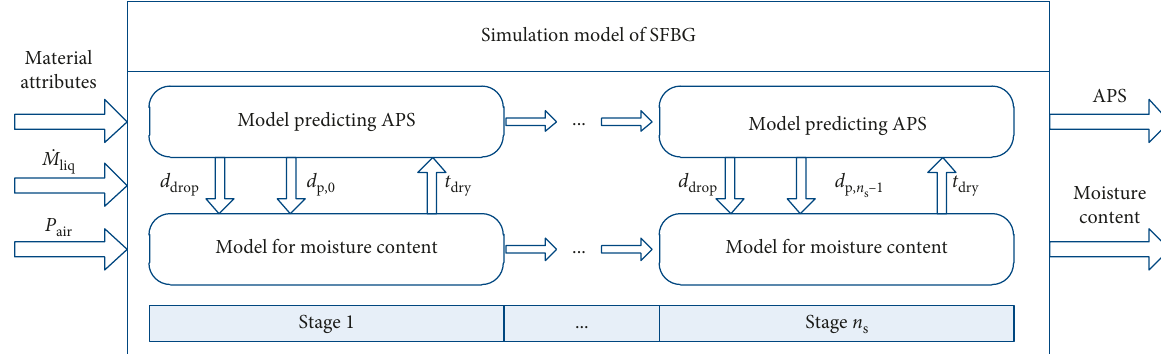
Figure 6: The coupling structure of the two models for SFBG.